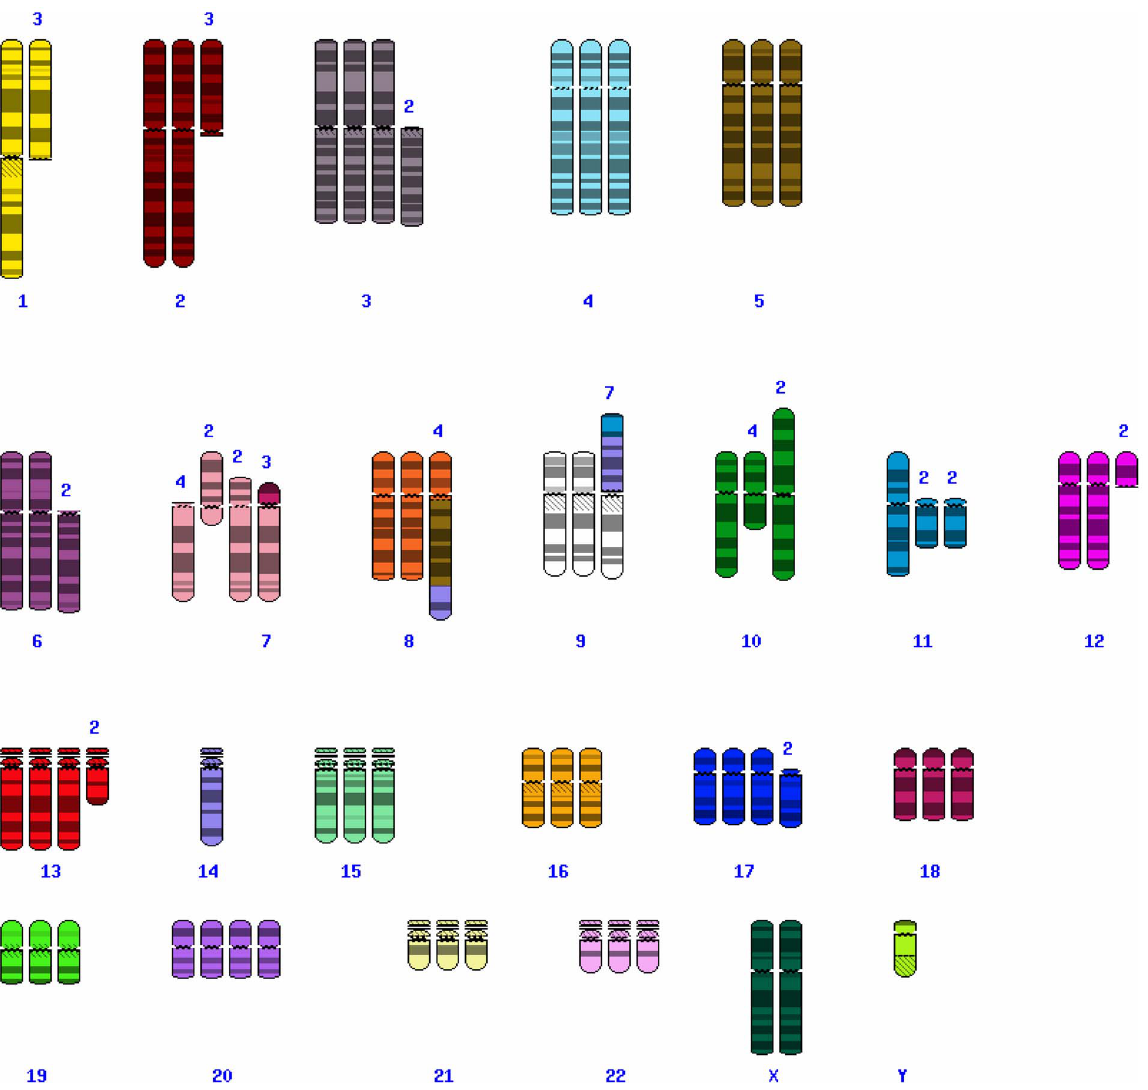
Figure 5. Complete SKYGRAM of LX-2 cells based on eight cells. Characters above rearranged chromosome ideograms are for numbers of metaphases with this aberration. Rearrangements recognized only once in SKY analysis are ignored. Based on this analysis, the complete SKYGRAM of LX-2 was determined to 64 , 83 , n3 + / 2. , XXY, 2 1, del(1)(q11) [3], del(2)(q11) [3], + del(3)(p11) [2], del(6)(p11) [2], del(7)(p11) [4], del(7)(q11) [2], del(7)(p15) [2], + der(7)t(7;18)(p11;p11) [3], der(8)t(5;8)(q11;q11)t(5;14)(q31;q23) [4], der(9)t(9;14)(p12;q11)t(11;14)(q14;q24)del(11)(q12) [7], del(10)(q22) [4],i(10)(q10) [2], der(11)del(11)(p11)del(11)(q22)x2 [2], del(12)(q11) [2], + del(13)(q21) [2],-14,-14, + del(17)(p11) [2], + 20[cp8], respectively. More detailed SKYGRAM data for LX-2 cells were deposited in the SKY/M-FISH & CGH database located at the National Center for Biotechnology Information that can be found at: http://www.ncbi.nlm.nih.gov/sky/skyquery.cgi. doi:10.1371/journal.pone.0075692.g005 (cf. Figure 4 and 6). The comparison of results obtained in SKY (Figure 4) and SNP array analysis (Figure 6) indicates similar chromosomal gains in 3q, 5p, 5q, 11q, 14q, 17q, 20 and losses in 1q, 7p, 8q, 9p, and 11p. Therefore, the SKY results of the eight metaphases seem to reflect a representative intersection of the complete culture genome used for microarray analysis.